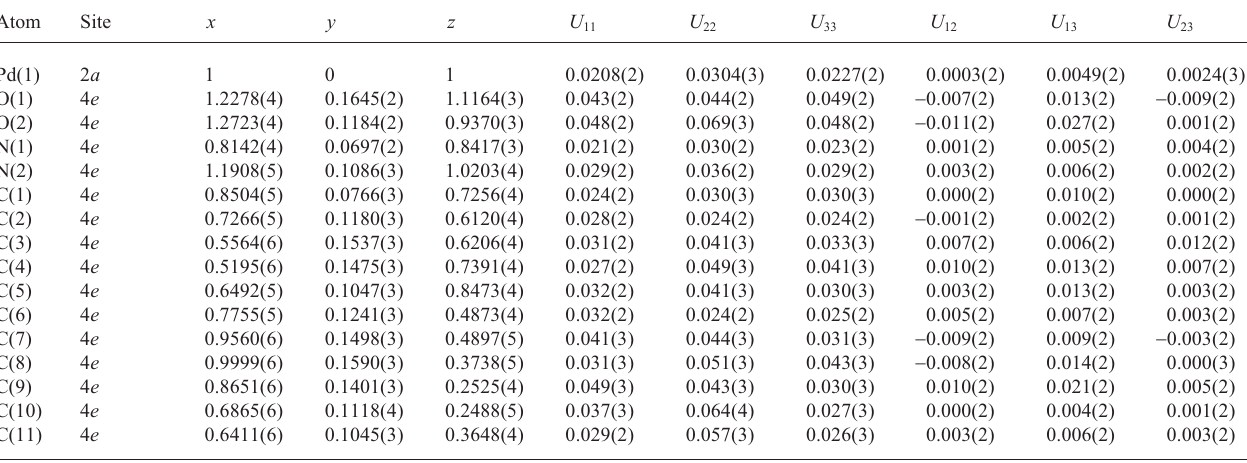
Table 3. Atomic coordinates and displacement parameters (in Å 2 )